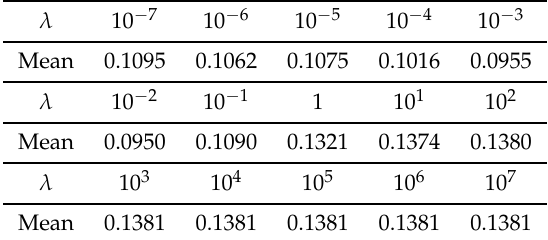
Table 8. Average Brier scores for the logistic regression model.